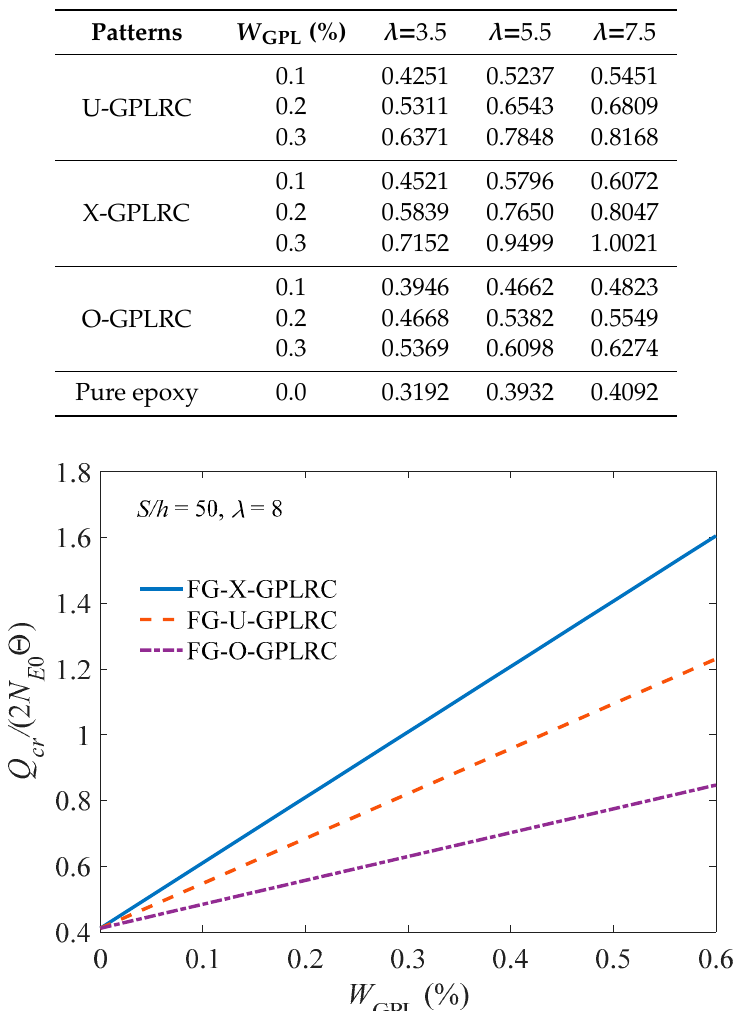
Table 2. Limit point buckling load of FG-GPLRC arches.